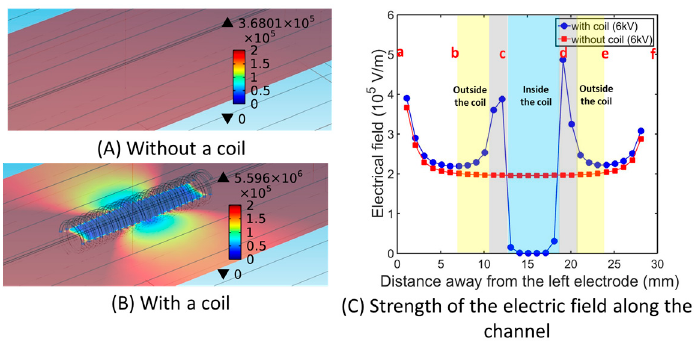
Figure 4. Simulation of the electric field in microfluidic devices. The simulated electric field strength in the device: ( A ) without a coil; ( B ) with a coil. The scarlet color indicates the electric field strength is above 2 × 10 5 V/m. The navy blue indicates the electric field is close to 0 V/m; ( C ) Simulated electric field strength along the observation channel: blue dots (with a metallic coil); red squares (without a coil). The applied voltage is 6 kV. The yellow regions represent the space outside the coil; the gray regions represent the inlet and outlet of the coil; the blue region represents the space inside the coil. Points “a”, “b”, “c”, “d”, “e” and “f” represent the left electrode, the inlet of the droplet flow, the inlet of the coil, the outlet of the coil, the outlet of the droplet flow and the right electrode respectively.